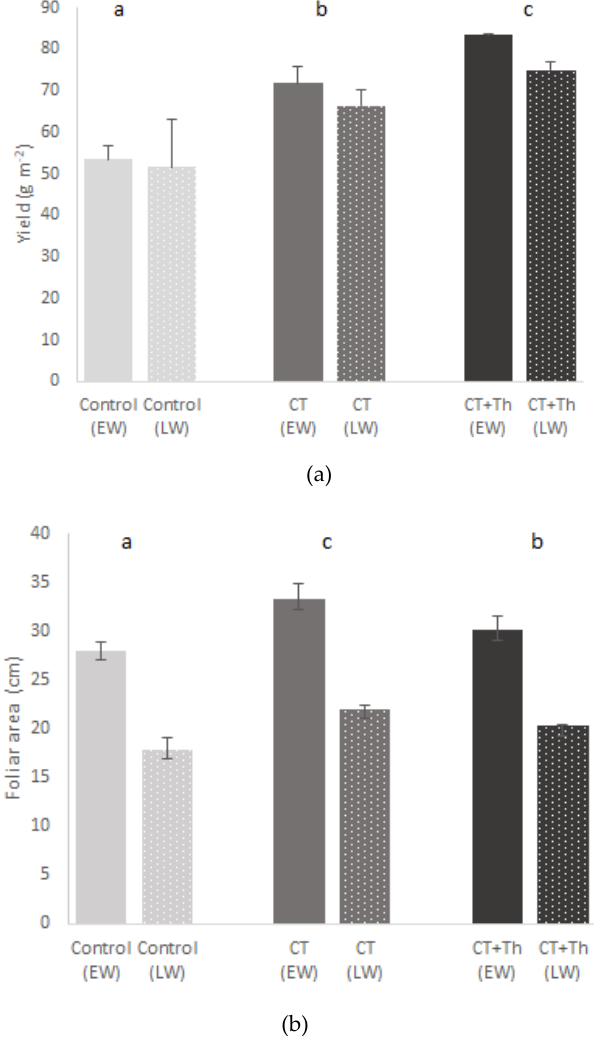
Figure 1. Effect of different compost tea (CT) treatments on yield ( a ) and foliar area ( b ) of baby spinach Figure 1. E ff ect of di ff erent compost tea (CT) treatments on yield ( a ) and foliar area ( b ) of baby in both experiments. Bars are mean values n = 3. Error bars indicate standard deviation. Control: